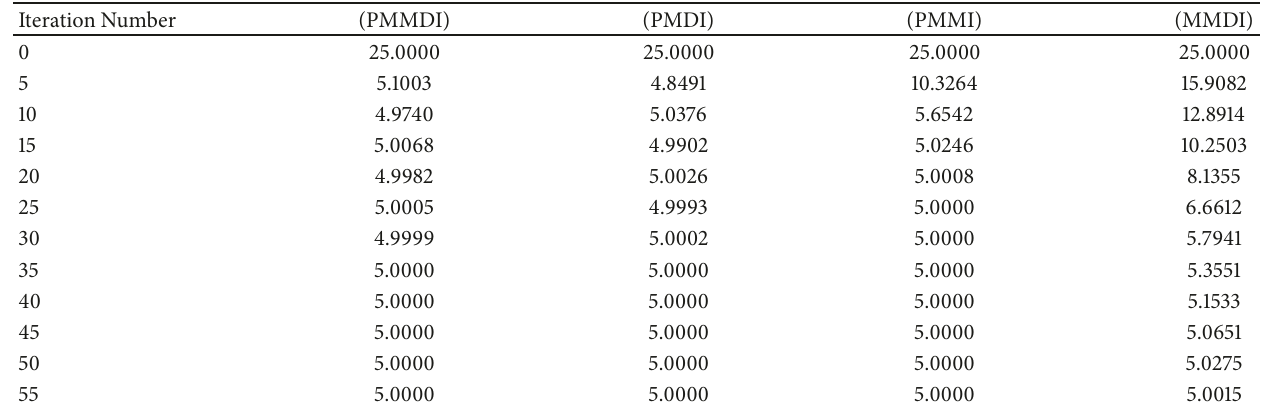
Table 2: A comparison of (PMMDI), (PMDI), (PMMI), and